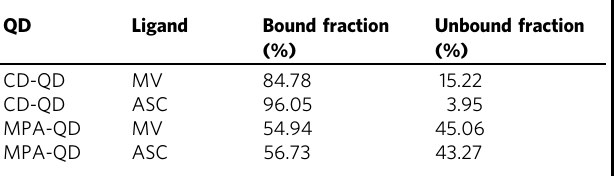
Table 2 Calculated bound and unbound fractions of chemicals on quantum dots.